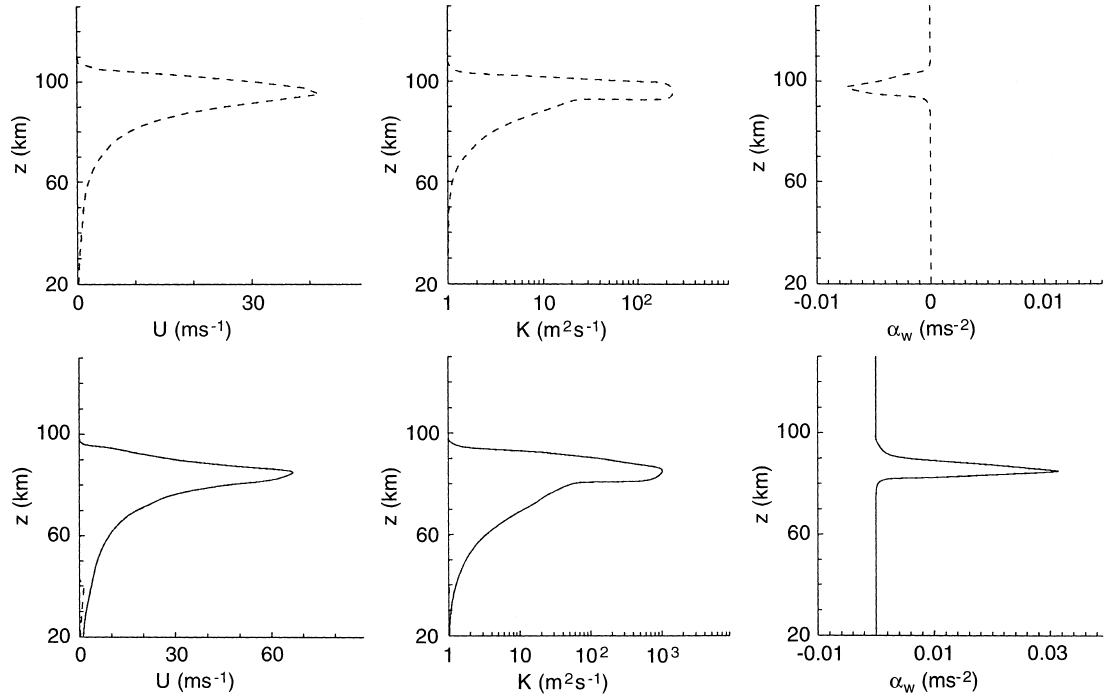
Fig. 4. Vertical profiles of the parameters of IGW harmonics with j c j (cid:136) 30m s (cid:255) 1 and (cid:114) (cid:136) 10 (cid:255) 3 s (cid:255) 1 propagated eastwards ( solid lines ), and westwards ( dashed lines ) in January ( top plots ) and July ( bottom